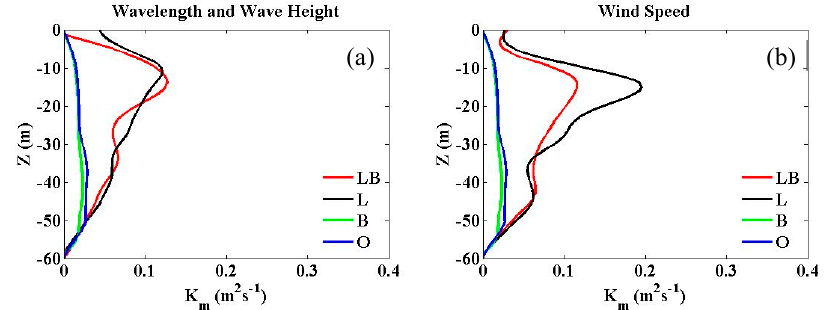
Figure 6. Vertical profile of the eddy viscosity K m for simulations with no BW and LC (blue); BW only (green); LC only (black); with LC and BW (red). Eddy viscosity is based on Stokes velocities calculated using Equation (3) ( a ) and Equation (5) ( b ).